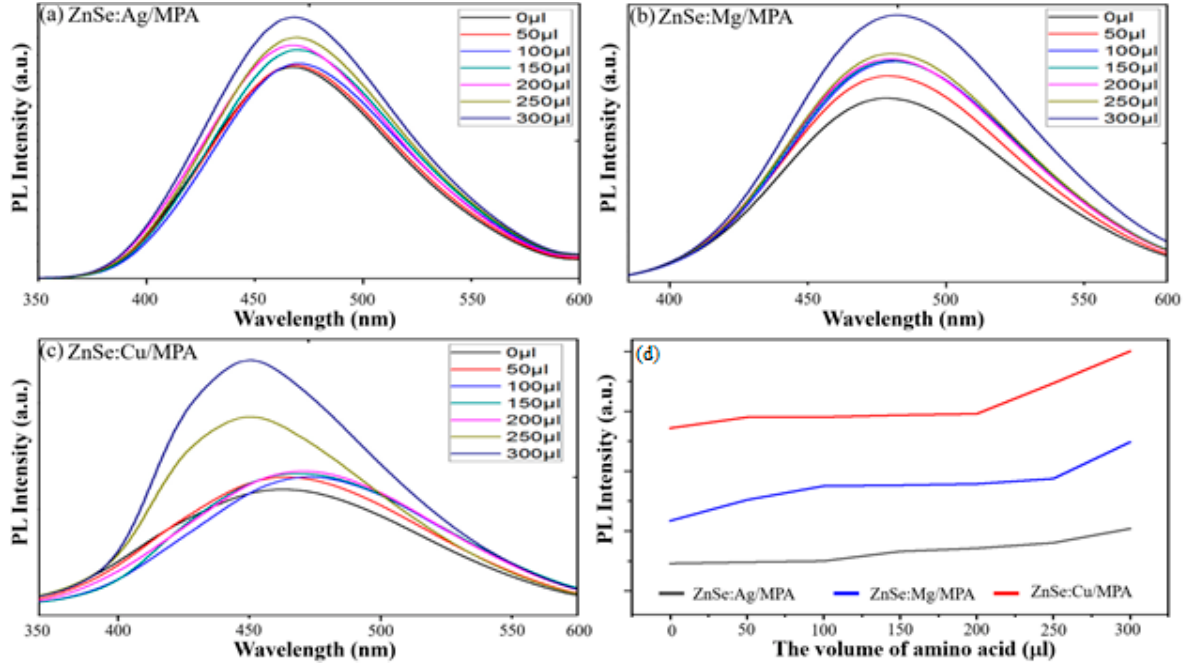
Figure 4. PL spectra of ZnSe:X-capped MPA combined with lysine: ( a ) ZnSe:Ag, ( b ) ZnSe:Cu, and ( c ) ZnSe:Mg; ( d ) the evaluation of the volume of lysine to the PL intensity at the maximum emission peak.